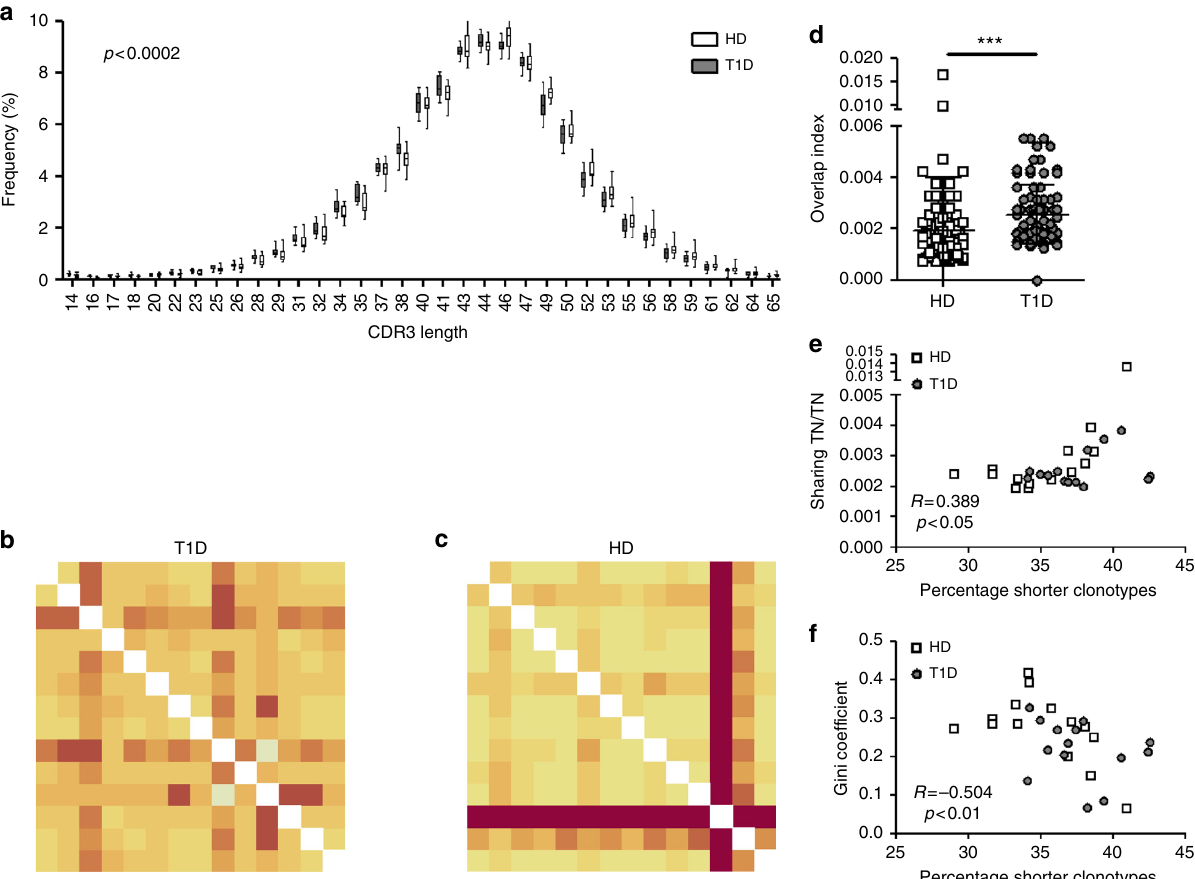
Fig. 3 Pre-selection TCRB sequences are shorter and more similar among type 1 diabetes patients. a Distributions of TCRB CDR3 length (in nucleotides) of pre-selection unique sequences show a bias towards shorter lengths in type 1 diabetes (T1D) patients (one-sided bootstrap univariate Kolmogorov – Smirnov test; p < 0.0002). b , c Overlap indices for pre-selection unique nucleotide TCRB sequences are higher in T1D patients ( b ) than